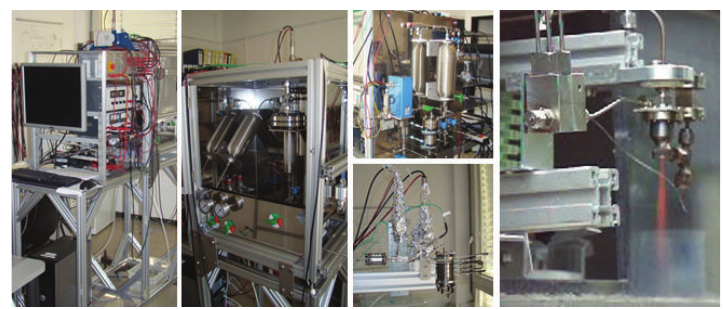
Figure 12: Catalyst and ignition assessment facilities.